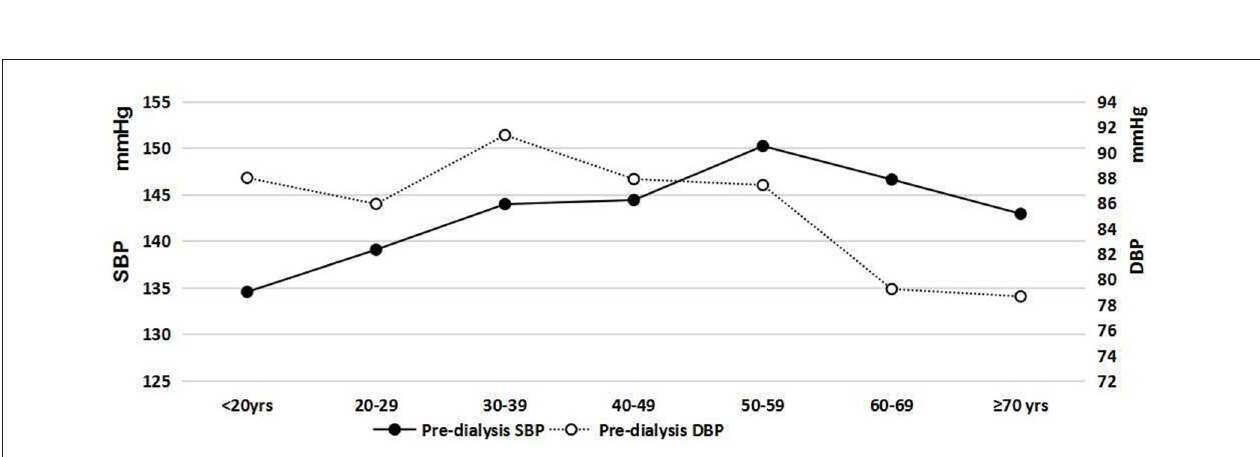
FIGURE 6 | Pre-dialysis blood pressure in different age